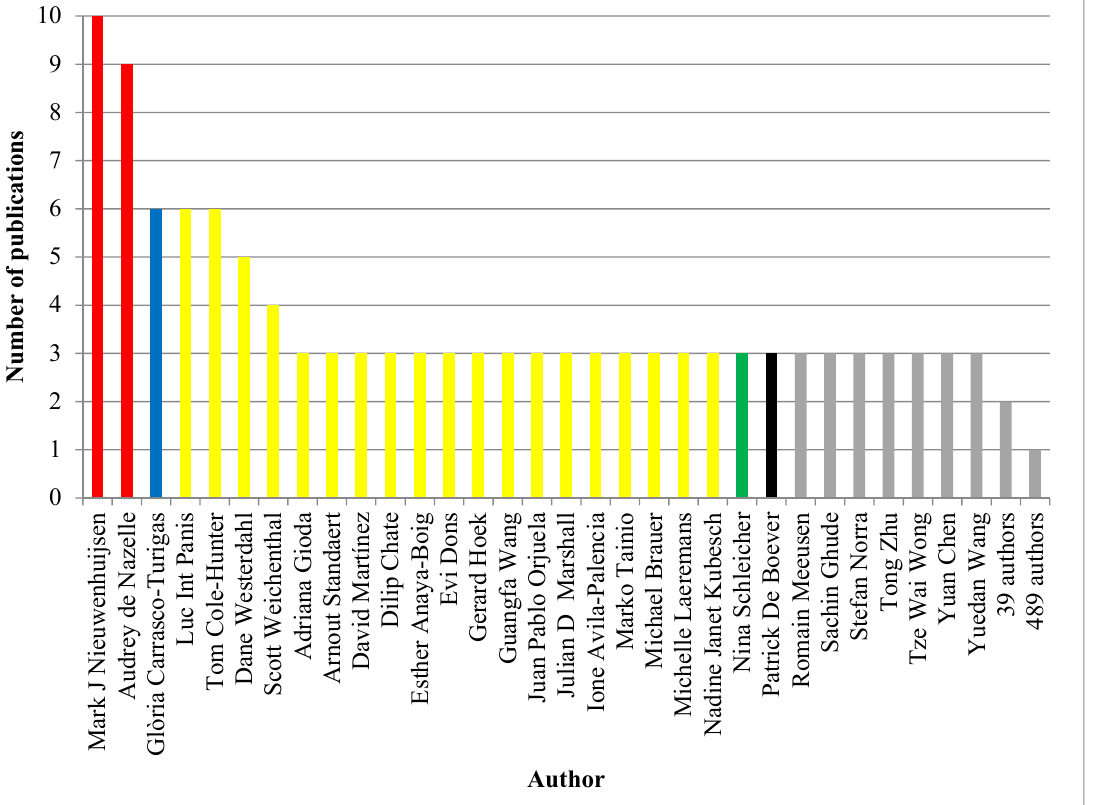
Figure 6. Number of publications by authors who had published studies about the topic.